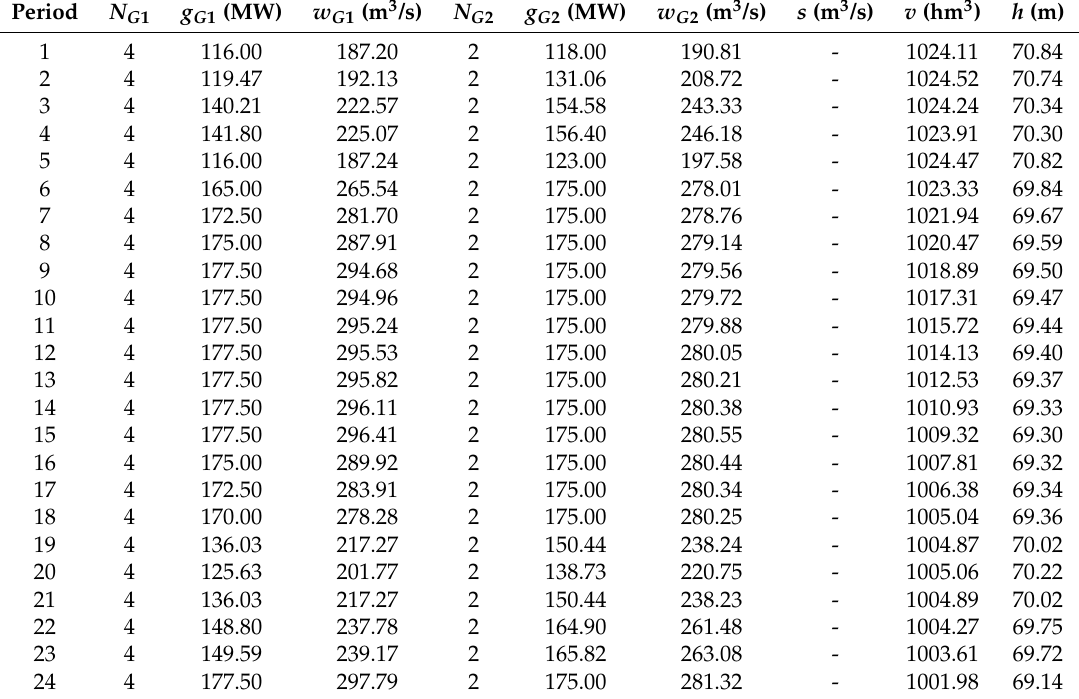
Table 12. Results with water outflow-based objective function-scenario